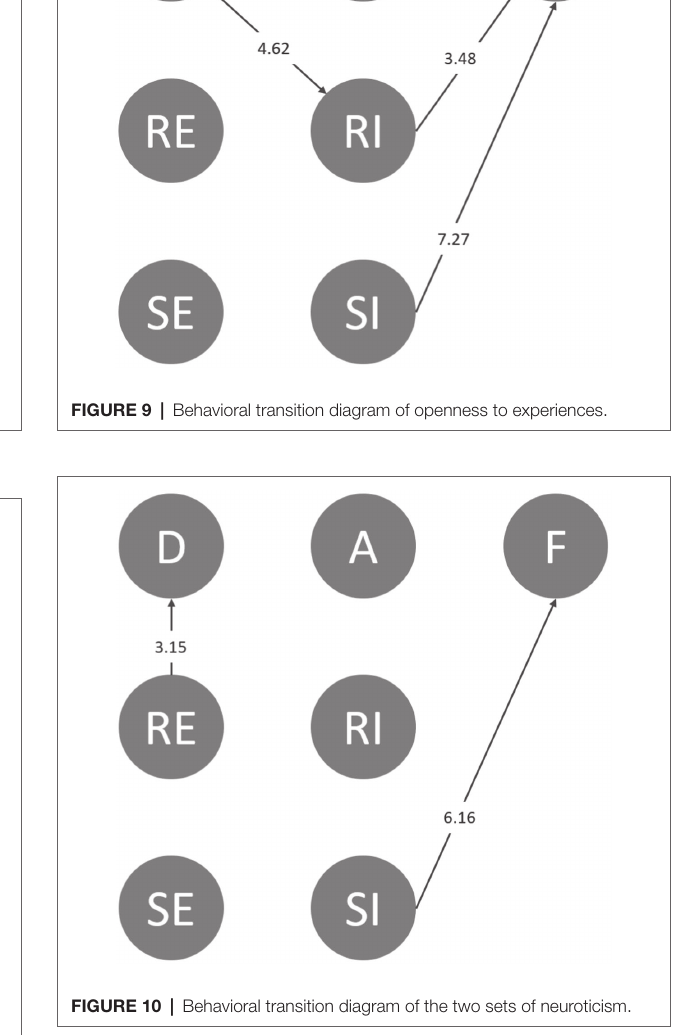
FIGURE 8 | Behavioral transition diagram of extraversion.